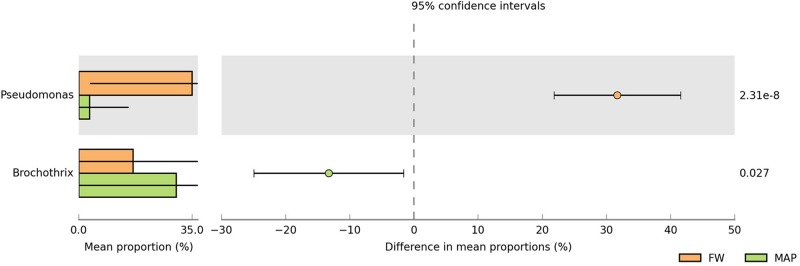
Extended bar plot showing the bacterial populations whose mean relative abundance differed between food wrap (FW) and modified atmosphere (MAP) packaging at genus scale. The relative abundance and the difference in mean proportions are illustrated for the statistically different taxa (p < 0.05).